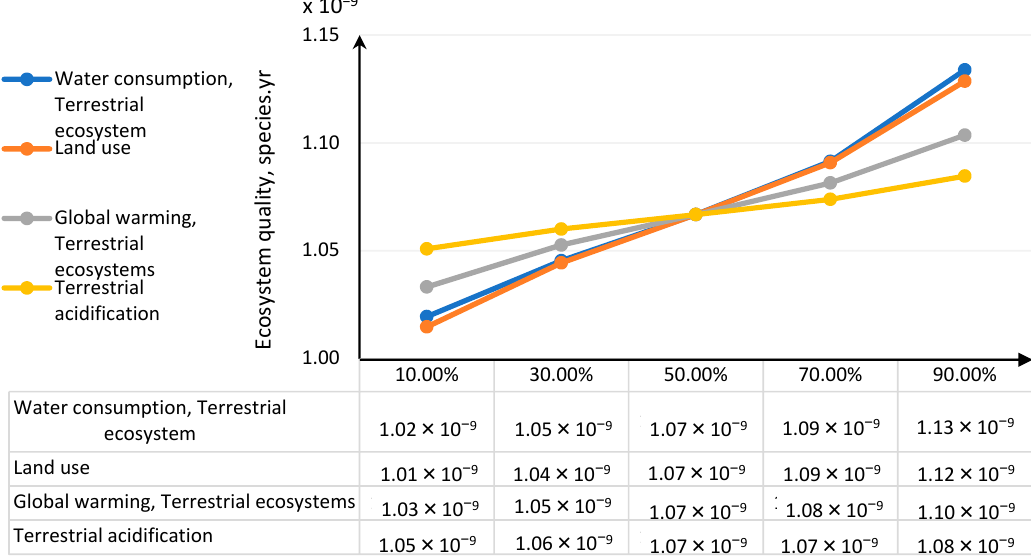
Figure 20. Tornado chart for the forecast of significant categories of impact on ecosystems – error bars show the mean standard error value.